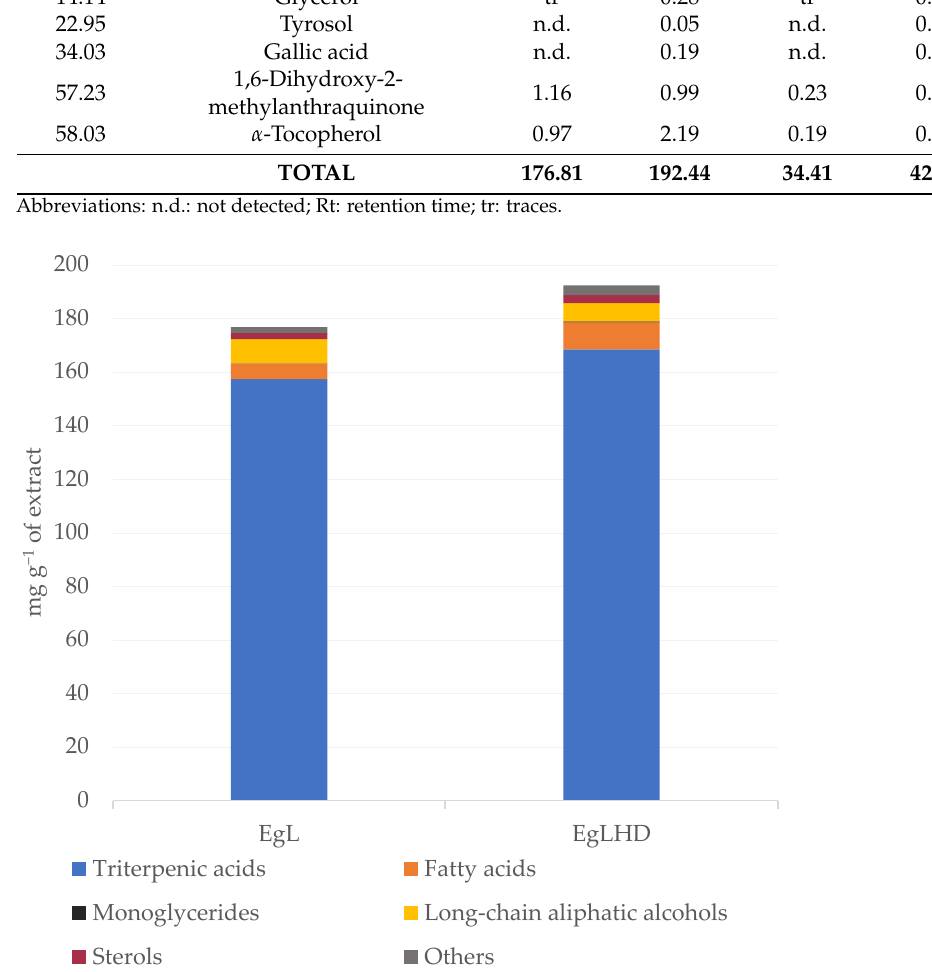
Figure 2. Main families of lipophilic compounds identified by GC–MS in dichloromethane (DCM) extracts of E. globulus leaves before (EgL) and after (EgLHD) hydrodistillation.